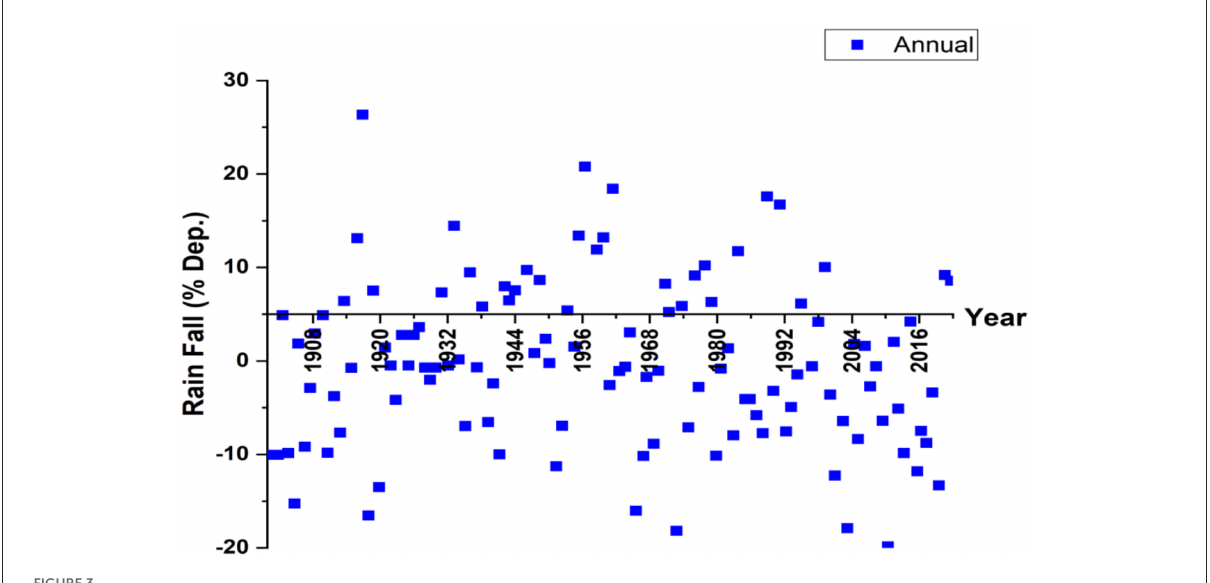
FIGURE3 Time series of percentage departure of annual rainfall in India (1901–2020).